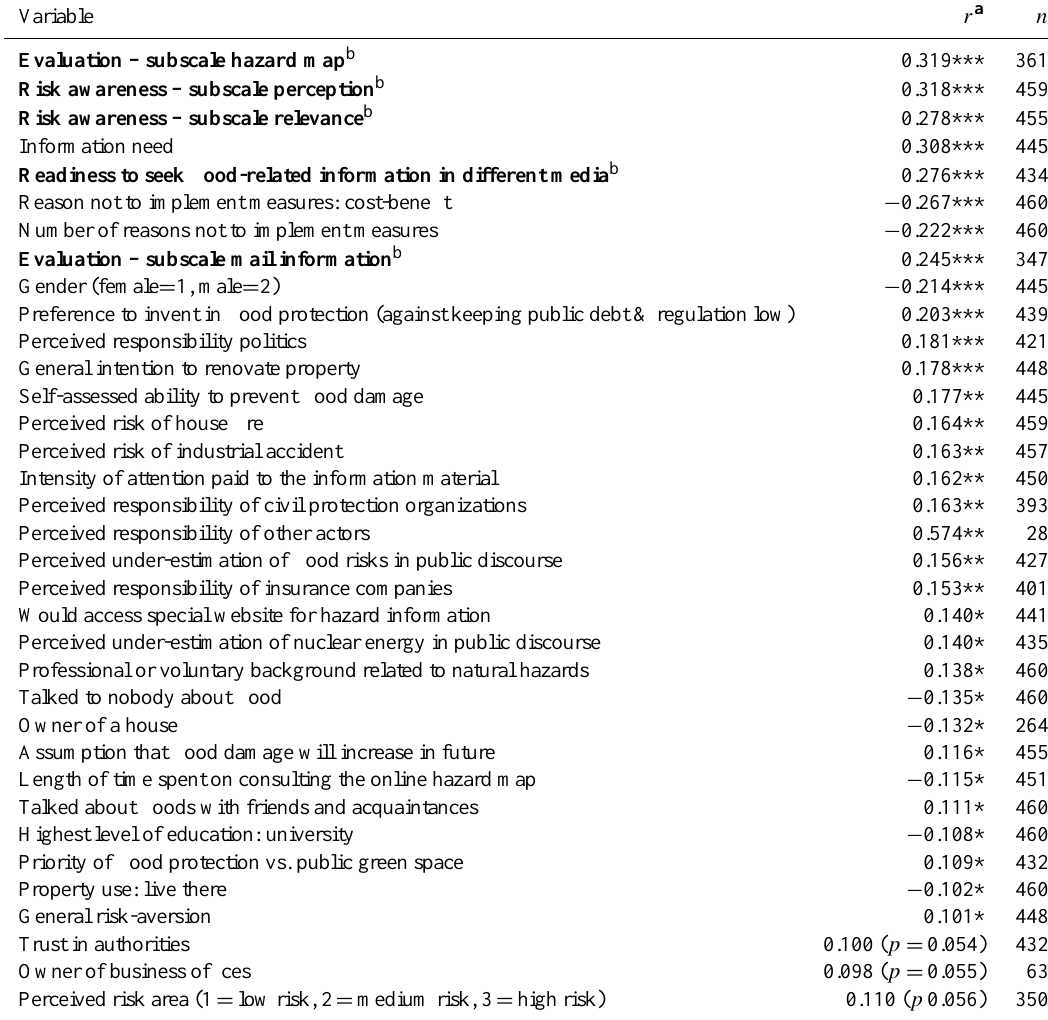
Table 2. Bivariate correlations of flood risk preparedness with other